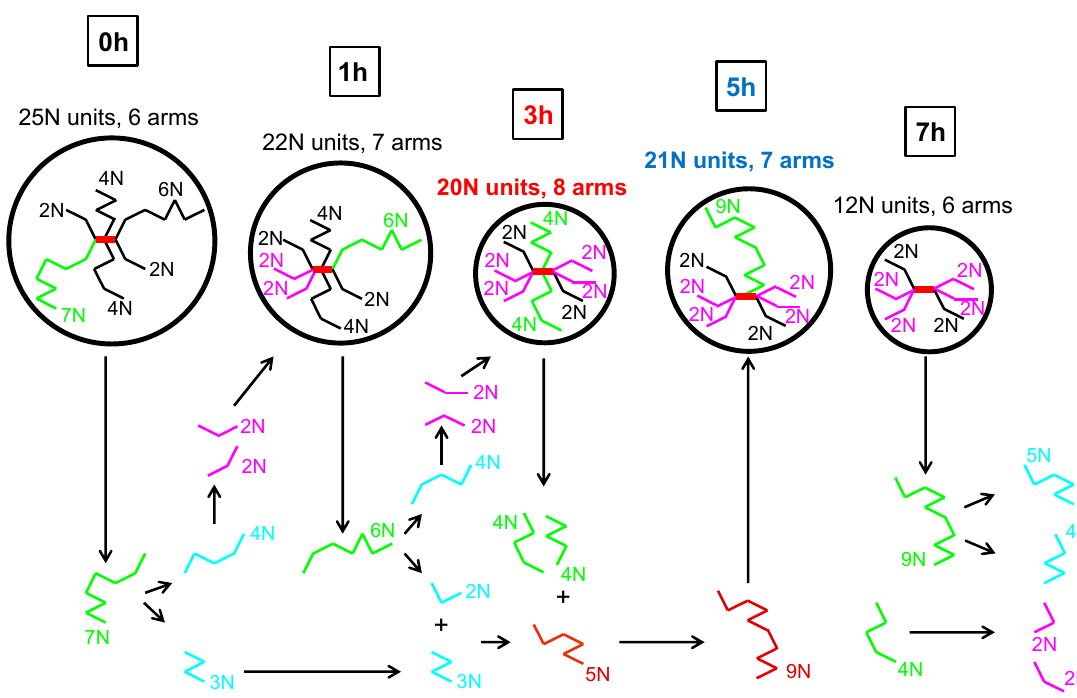
Figure 12. Simplified visualization of possible changes in “characteristic” polymer coil for investigated branched PP at 180 °C during thermal degradation.